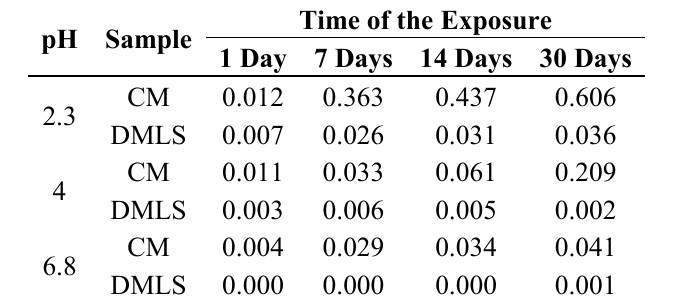
Table 3. The released Cr from the CM and DMLS alloys (μg per cm 2 ) in artificial saliva of pH = 2.3, pH = 4 and pH =